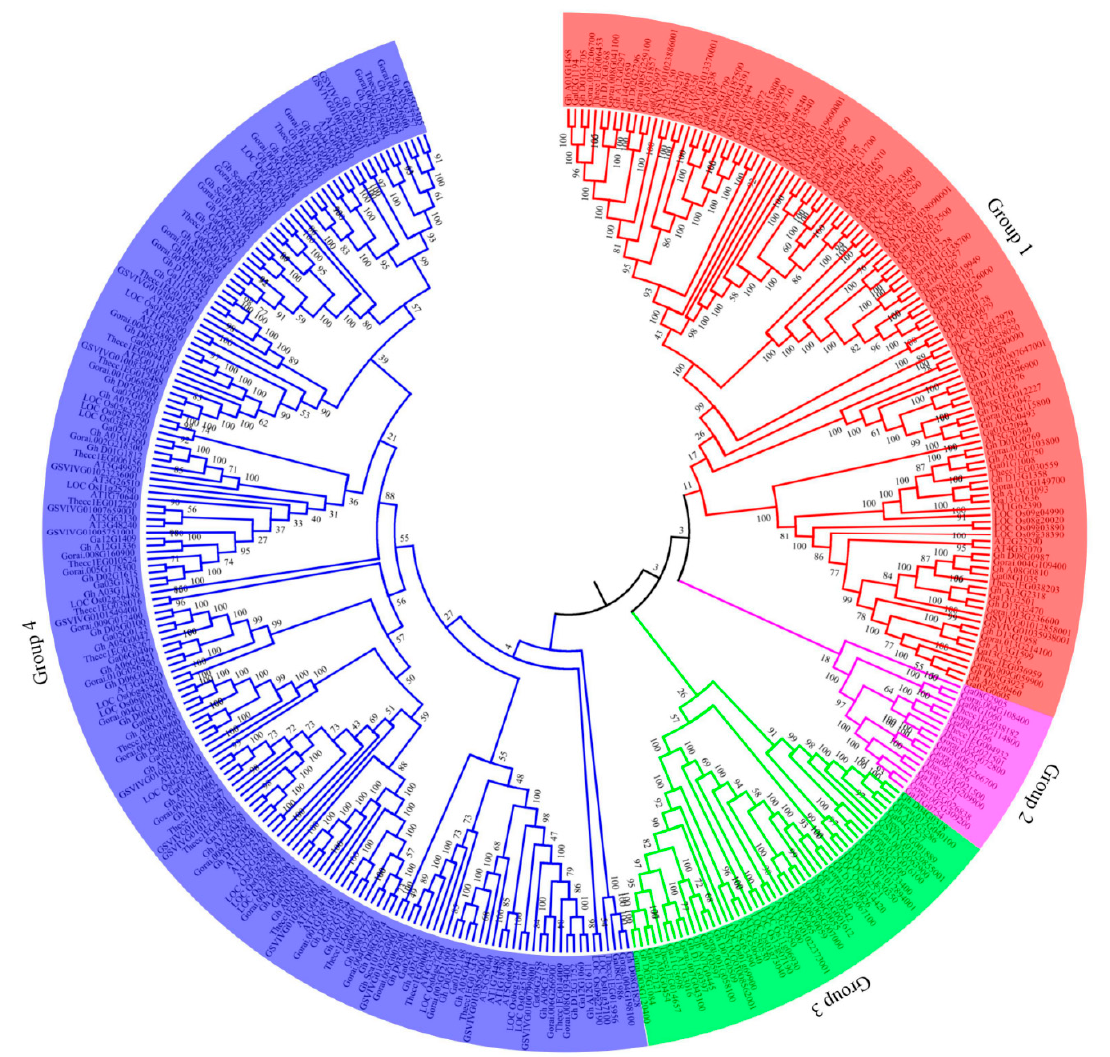
Figure 1. Phylogenetic tree analysis of the proteins encoded by the NLP genes in cotton and other plants. Different colours represent different groups, red: group 1, purple: group 2, green: group 3 ′ and blue: Members of group 4. AT: Arabidopsis thaliana , LOC: Oryza sativa , Thecc: Theobroma cacao , GSVIVG: Vitis vinifera , Gorai: Gossypium raimondii , Ga: Gossypium arboreum and Gh: Gossypium hirsutum. 2.3. Chromosome Mapping and Subcellular Localization Prediction Analysis of the Cotton Proteins Encoded